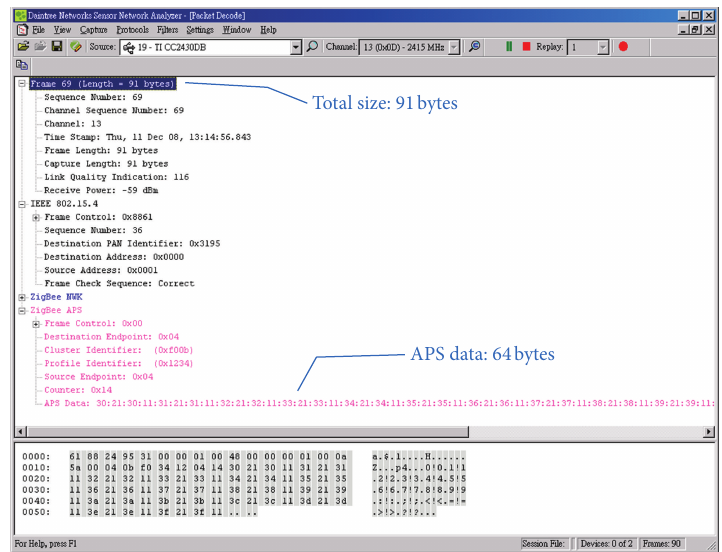
Figure 9: Sniffed packet: the packet size used for performance analysis is 91 bytes.